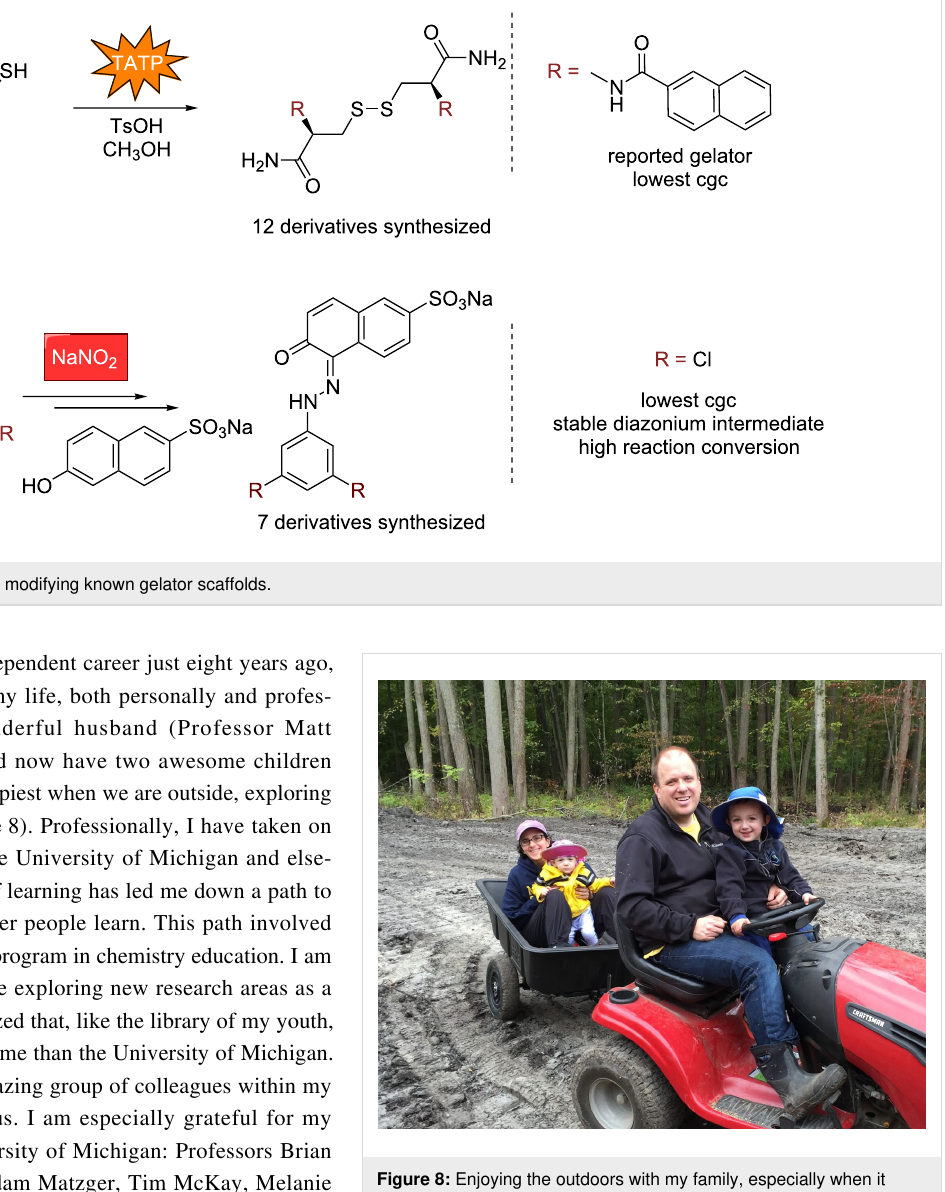
Figure 8: Enjoying the outdoors with my family, especially when it involves mud! Photo credit: Donald A.